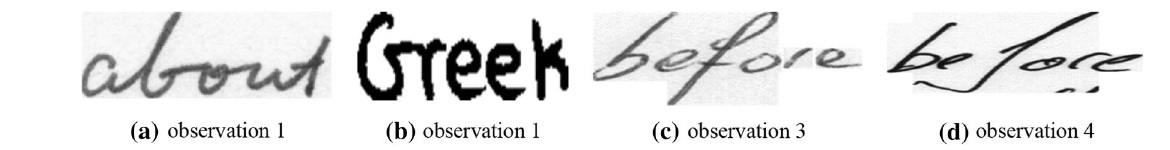
Fig. 3 Examples of word images to describe four different observations while estimating the upper profile of a word image